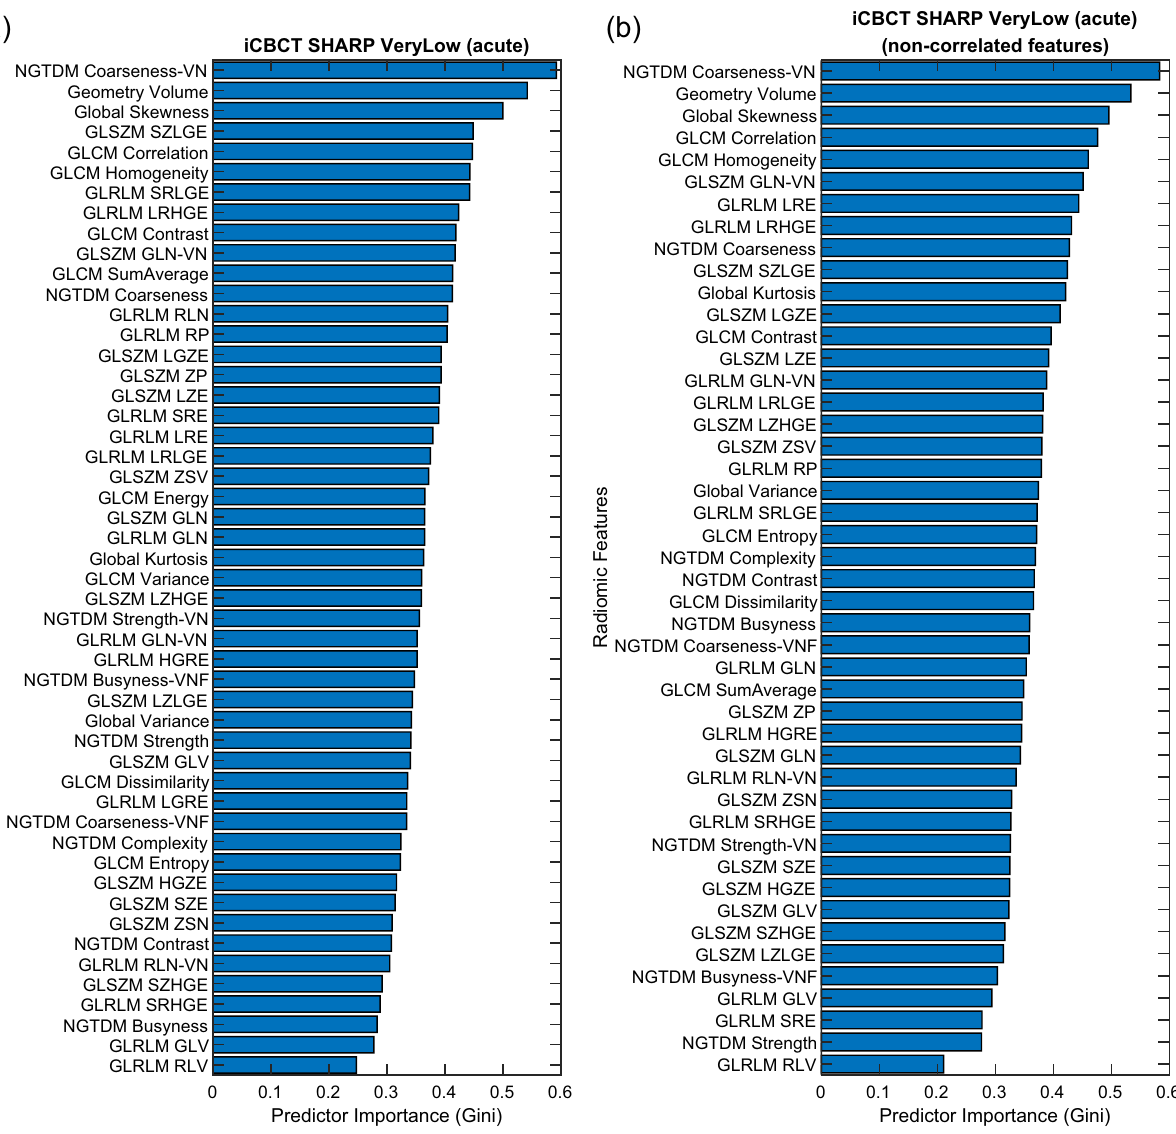
Figure 4. During the feature selection phase, correlated DRF were filtered out from ( a ) the initial predictor importance ranking to produce ( b ) the final predictor importance ranking after removing the lower ranked correlated features using ( b ) the Correlation Matrix between the DRF. This example corresponds to iCBCT- SHARP-VeryLow-Llo-1 for Sub-Acute GU